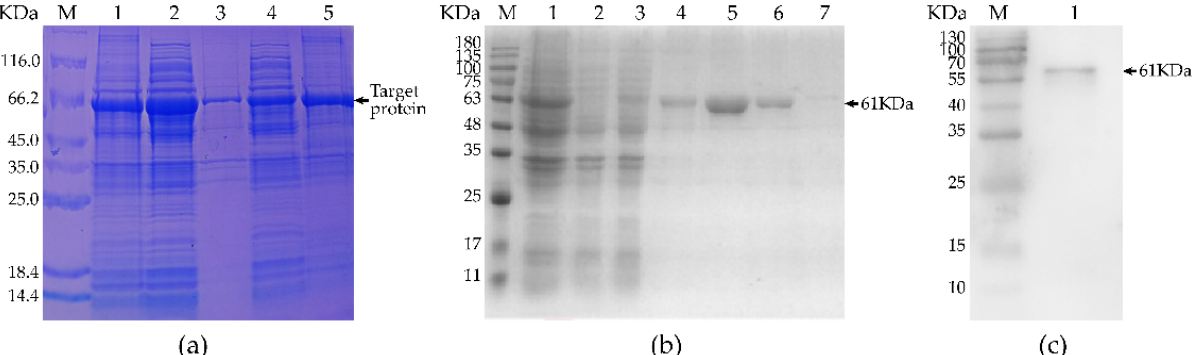
Figure 2. Western blotting to detect the purified recombinant protein. ( a ) M indicates the protein standard marker. The first lane presents the total protein before induction. Lanes 2 to 5 indicate the supernatant lysate of induced recombinant bacteria at 20 ◦ C, the precipitate of the lysate of induced recombinant bacteria at 20 ◦ C, the supernatant lysate of induced recombinant bacteria at 37 ◦ C, and precipitate of the lysate of induced recombinant bacteria at 37 ◦ C, respectively. ( b ) M indicates the protein standard marker. The first lane shows the total protein before induction. The second lane contains the filtered fluid containing the residual protein (excluding the target protein) from the supernatant of lysate of induced recombinant bacteria. The supernatant of the lysate of induced recombinant bacteria containing both bacterial proteins and the target protein is presented in the third lane. The fourth lane is target protein purified with elution buffer containing 100 mmol/L imidazole. The fifth lane is target protein purified with elution buffer containing 200 mmol/L imidazole. The wash buffer elution (50 mmol/L imidazole) is shown in the sixth lane (target protein and hybrid protein). The wash buffer elution containing 20 mmol/L imidazole is presented in the seventh lane (target protein and hybrid protein). ( c ) M indicates the standard protein marker. The first lane shows the purified rMseno protein.